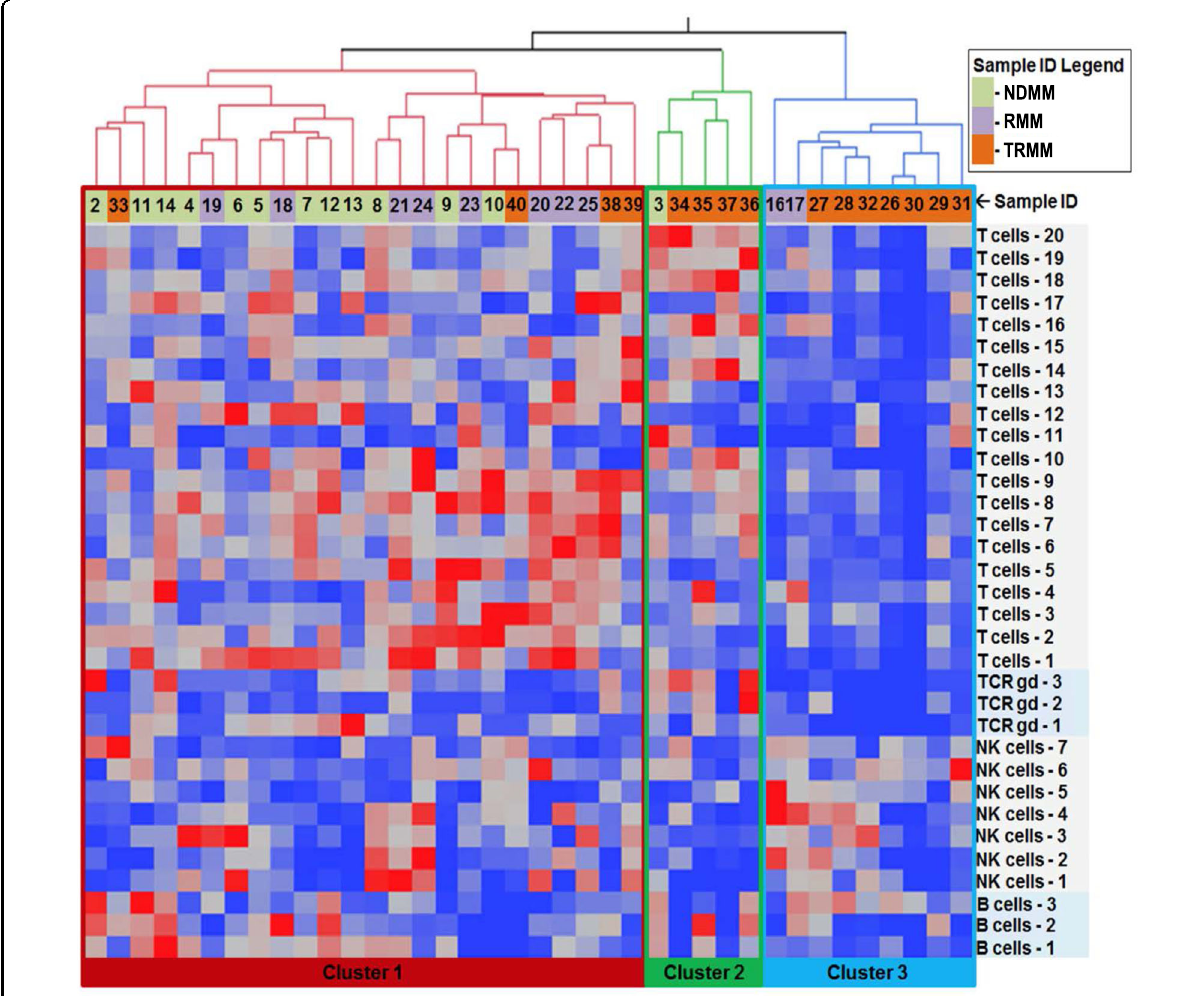
Fig. 1 Hierarchical clustering of patients based on immune subset frequencies (% of total CD45 + cells) identi fi es three distinct immune clusters. Samples represent patients with newly diagnosed MM (NDMM), relapsed MM not refractory to anti-CD38 antibodies (RMM), and relapsed MM that are triple refractory